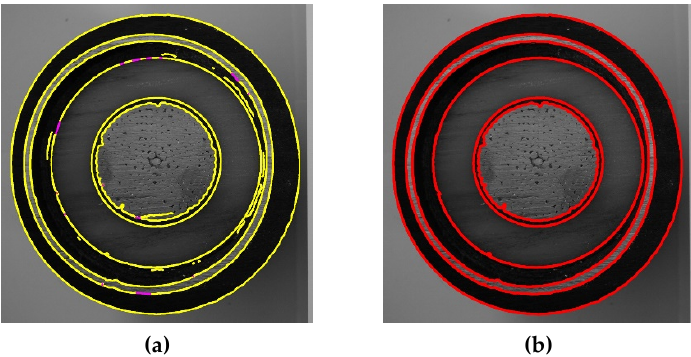
Figure 21. Arc-based edge connection result. ( a ) All connection locations, in which yellow dots are previous result and magenta dots are connections; ( b ) Closed initial C k after arc connection.